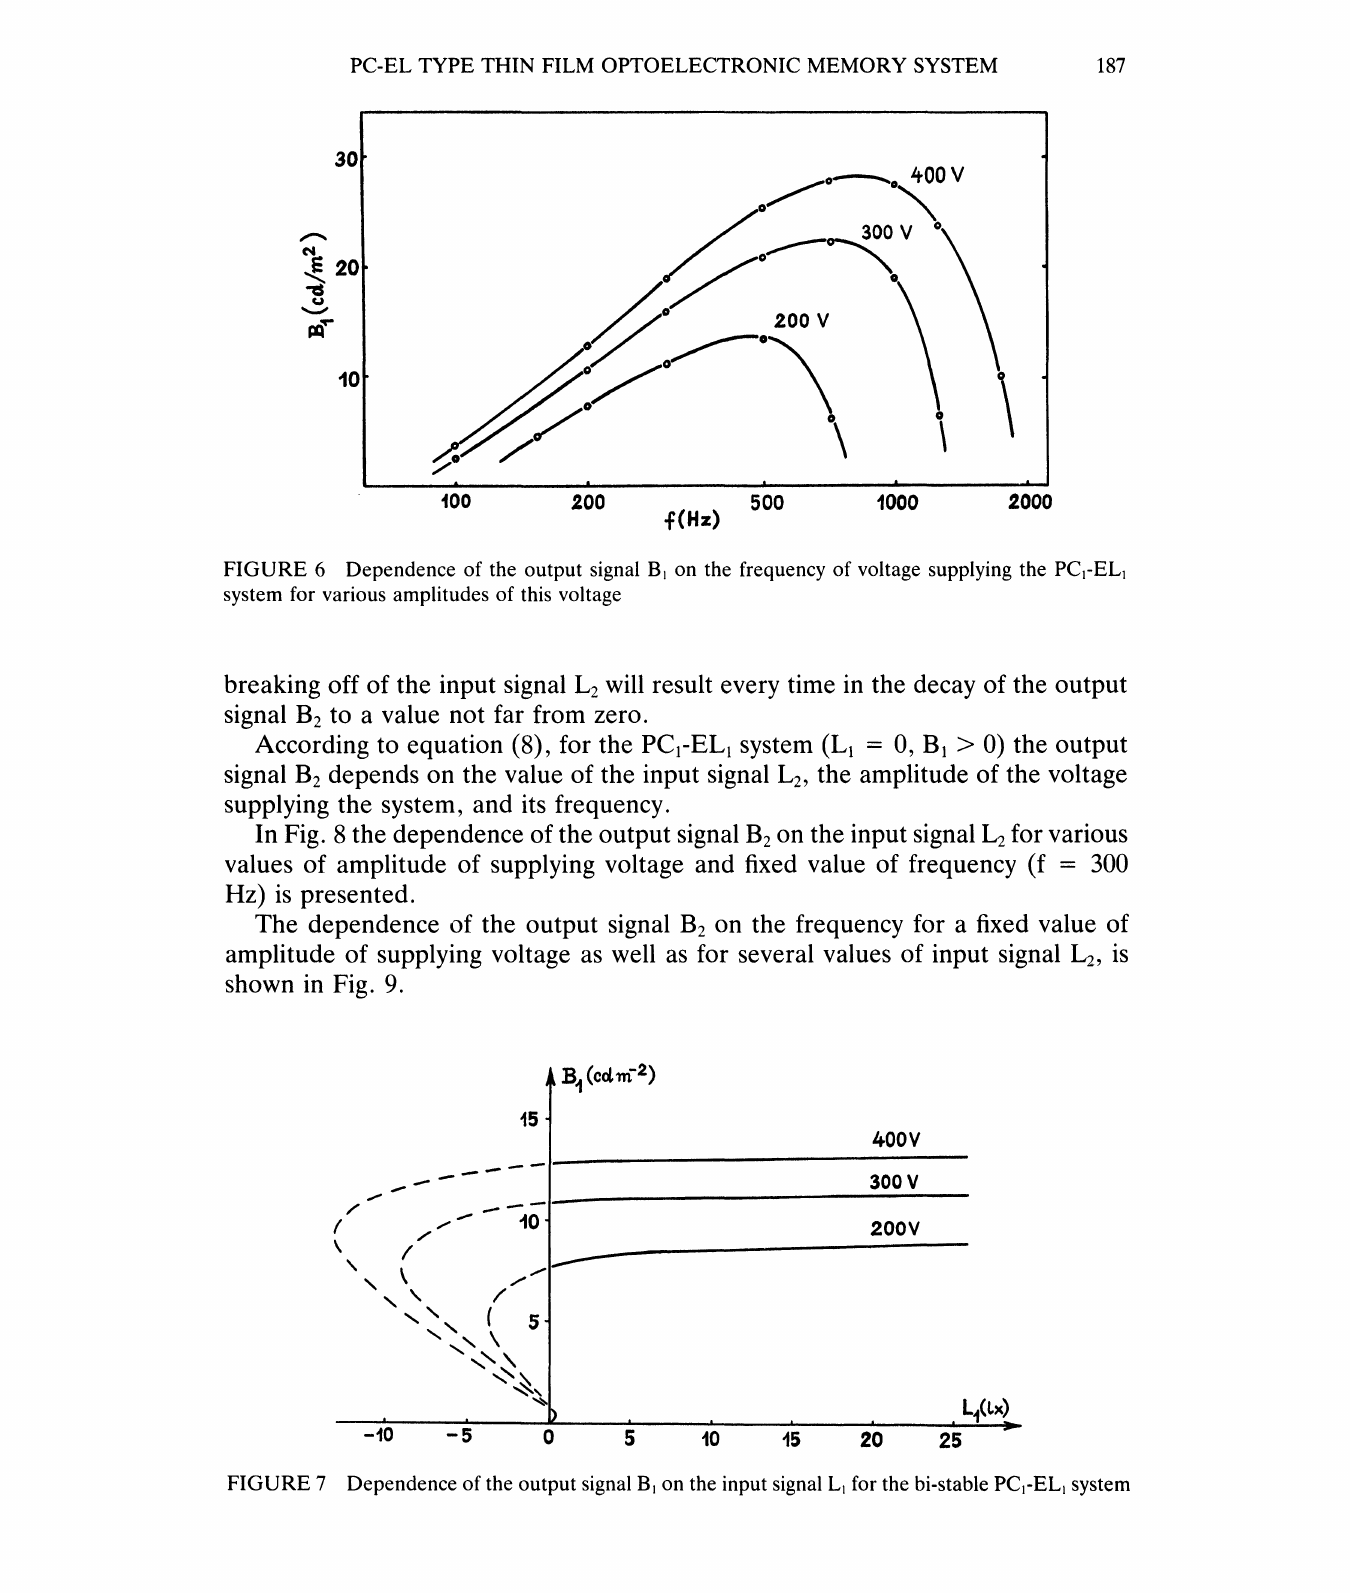
FIGURE 7 Dependence of the output signal B on the input signal L for the bi-stable PC-EL